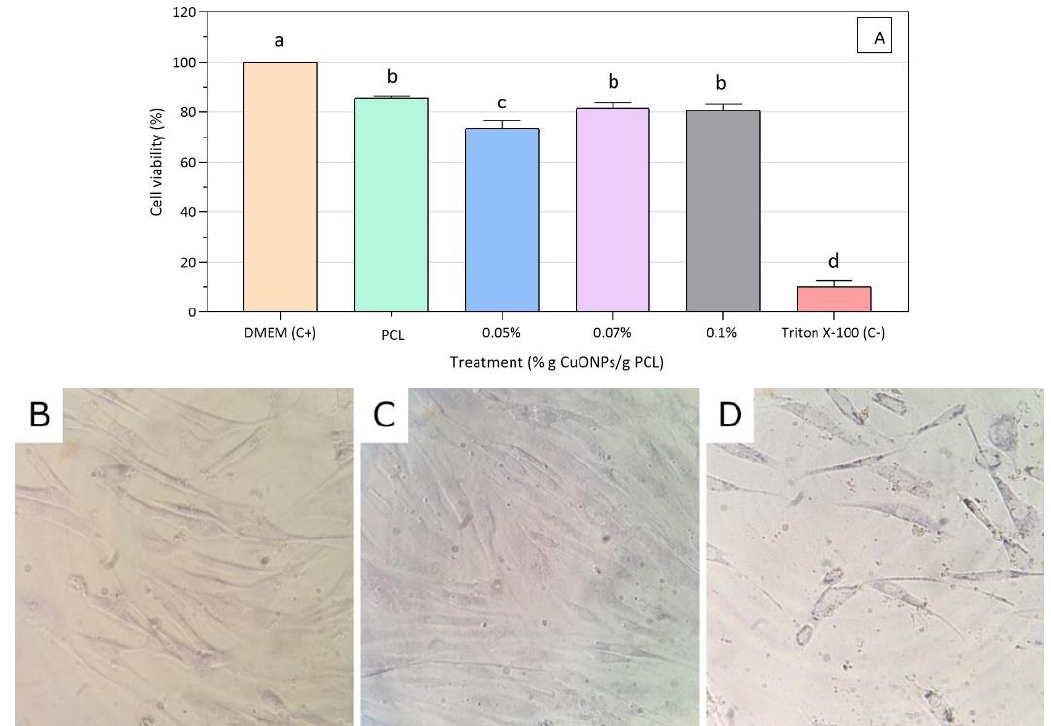
Figure 6. Viability results for HFF-1 cells exposed to neat PCL and active PCL films. ( A ): Viability test of the extracts of active PCL films on HFF-1 cells after 24 h of exposure, ( B ): HFF-1 with PCL + 0.07% CuONPs extract, ( C ): HFF-1 cells with Dulbecco’s Modified Eagle Medium (DMEM), ( D ): HFF-1 cells with Triton XCX-100; 40x magnification for the all three micrographs. Mean values with different letters represent significant differences ( p < 0.05) among the samples as determined with a one-way analysis of variance (ANOVA) and Tukey’s multiple comparison tests.